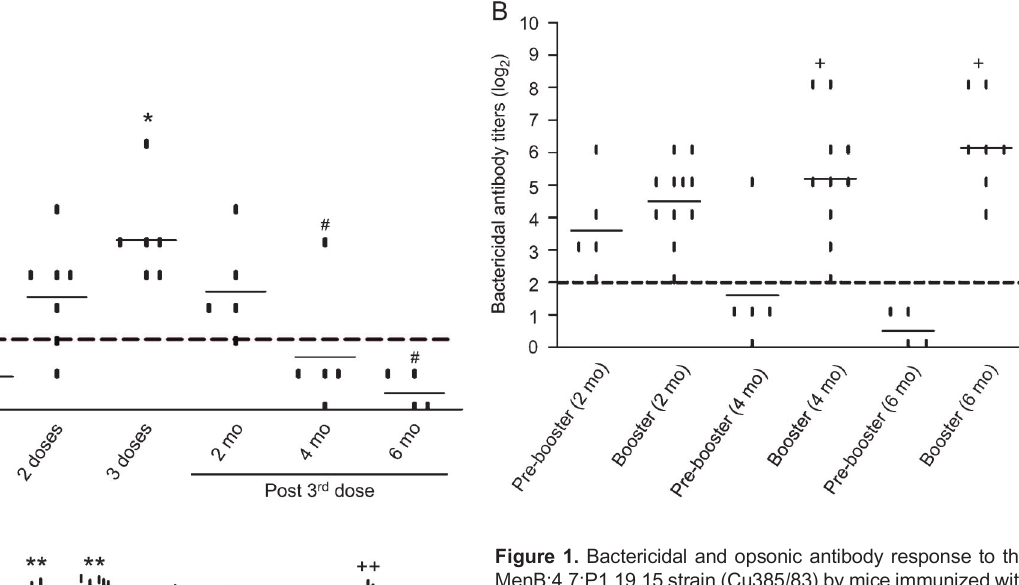
Figure 1. Bactericidal and opsonic antibody response to the MenB:4,7:P1.19,15 strain (Cu385/83) by mice immunized with VAMENGOC-BC H . Lines show the average serum antibody titers (log 2 ) detected. A , Bactericidal antibodies at 14 days after each vaccine injection during the primary immunization schedule; B , bactericidal antibodies detected before (pre- booster) and 14 days after booster injections given at 2, 4, and 6 months (mo) after the primary immunization schedule; C , opsonic antibodies at 14 days after each vaccine injection, at 2, 4, and 6 months post-third dose and at 14 days post-booster injection applied at 6 months. The dashed line in A and B represents the protective bactericidal titer (4 or log 2 of 2). The points represent each individual antibody level, which was tested at least twice for each sample. *P , 0.05 compared to 1 and 2 doses. # P , 0.05 compared to 3 doses. + P , 0.05 compared to pre-booster. **P , 0.05 compared to 1 dose or 2 doses. ## P , 0.05 compared to 3 doses. ++ P , 0.05 compared to pre-booster. The paired t -test was used for statistical